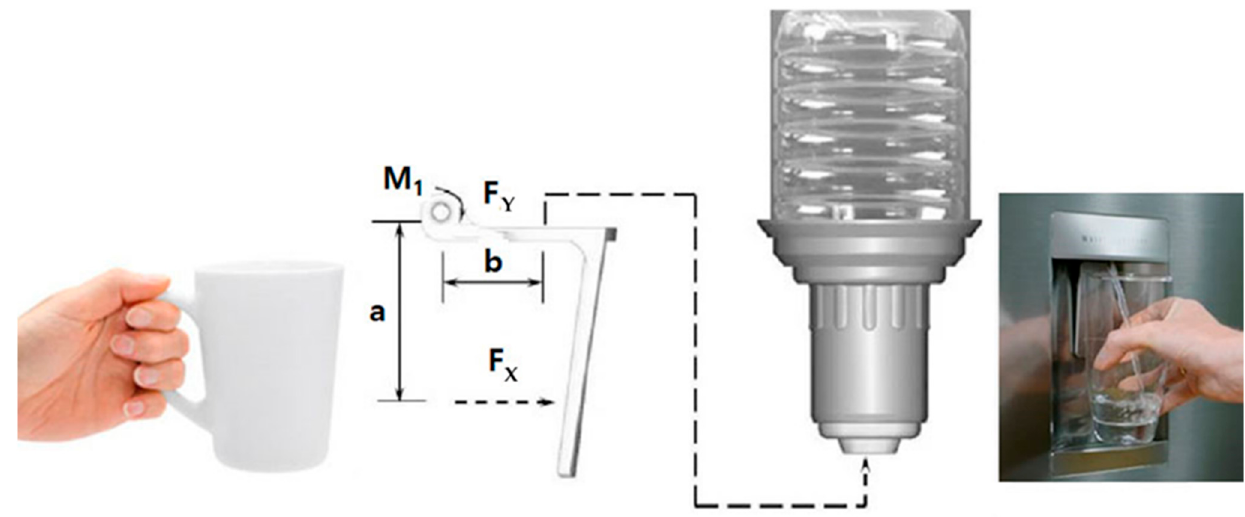
Figure 9. Practical designs of the dispenser system.